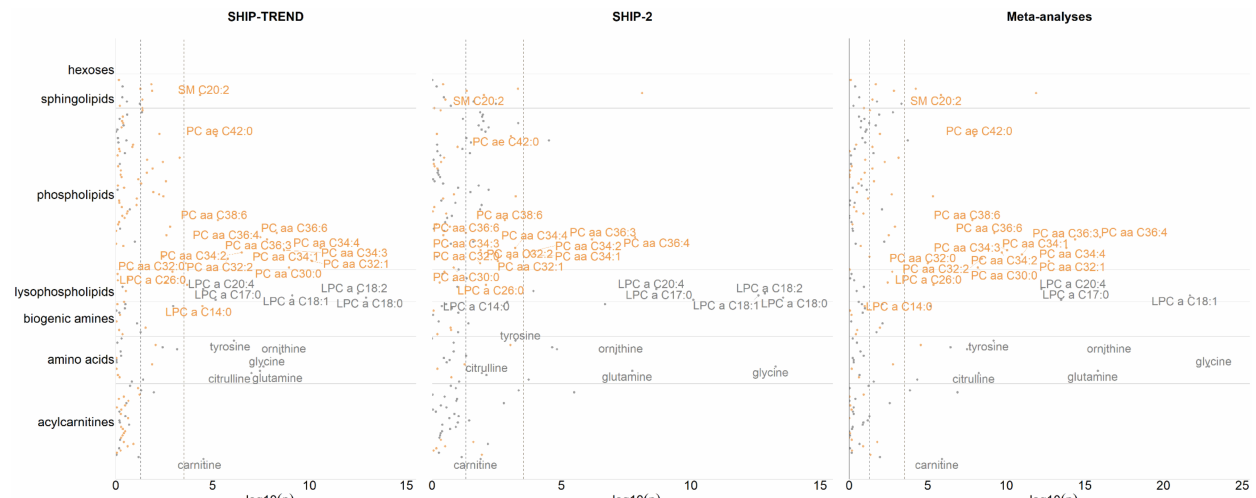
Figure 2. Main effects of OC use on the concentrations of the metabolites, including cohort–specific and meta–analytic results. Labeled metabolites were Bonferroni–corrected statistically significant in SHIP–TREND. The Bonferroni–corrected significance level ( p < 2.924 × 10 − 4 ) is represented by the right dashed line, and the nominal significance level ( p < 0.05) by the left dashed line in each panel. Analyses were adjusted for age, time of blood sampling, fasting time (restricted cubic splines), waist circumference, white blood cell count, red blood cell count, thrombocytes count and cystatin C concentrations. Gray = metabolite concentrations lower in OC users than in OC nonusers; yellow = metabolite concentrations higher in OC users than in OC